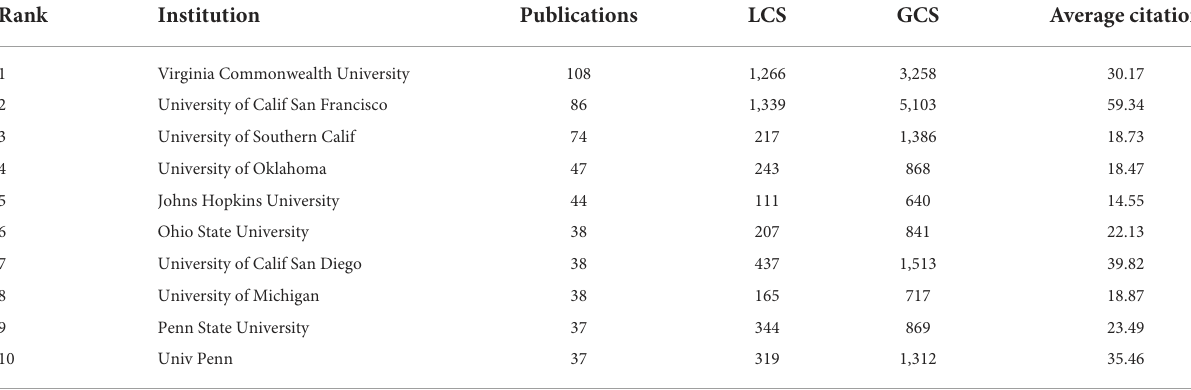
TABLE 2 The top 10 productive institutions concerning electronic cigarettes research.